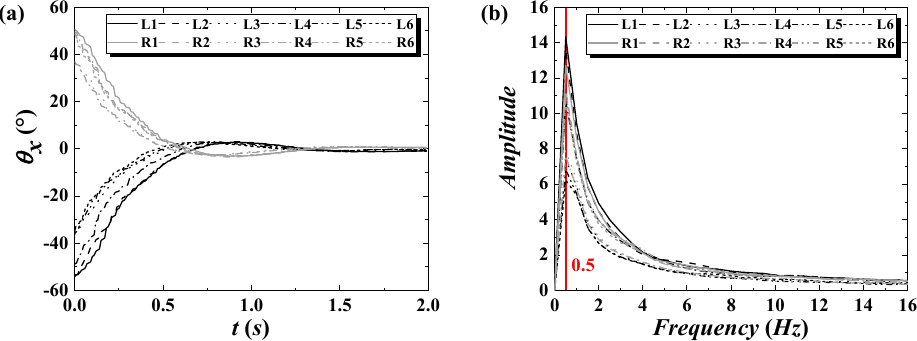
Figure 6. Results of free fluctuation tests of the flap for ( a ) the time variation of the rotation angle θ x measured by the gyro sensor and ( b ) the natural frequency. L1–6 and R1–6 denote the cases of the flap initially tilted to the onshore (left side) and offshore sides (right side), respectively.